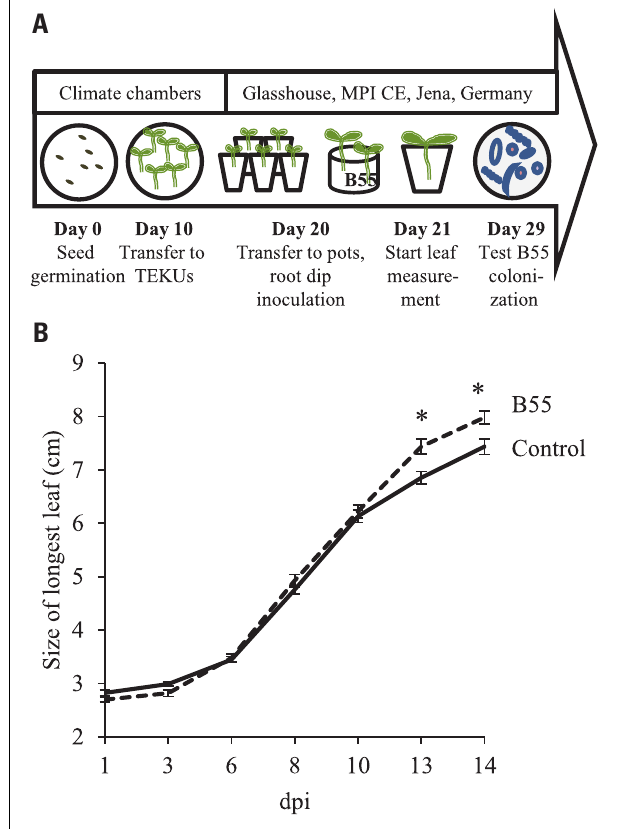
FIGURE 4 | Effects of a “late-stage” B55 inoculation onWT plants. Timeline and experimental design (A) . Mean ( ± SE) length of the longest leaf of mock- or B55-inoculatedWT N. attenuata plants cultured in the glasshouse (B) .WT plants were grown in a sand-filledTeku pots until day 20, before they were inoculated with B55 and transferred to 10 cm round pots containing lecaton and sand (PLSD test of an ANOVA between mock- and B55-inoculated plants: * P < 0.05). dpi, days post infection. n =